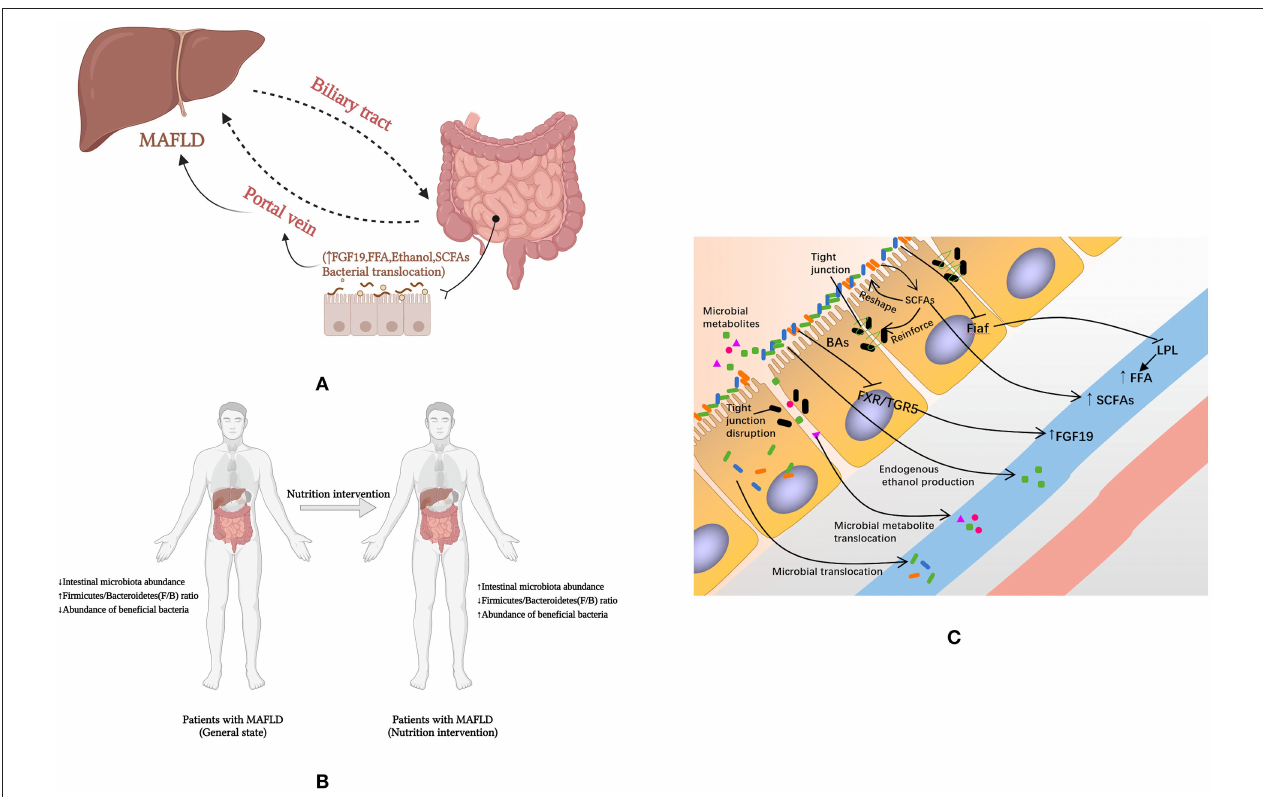
FIGURE 2 | How nutrients affect MAFLD through intestinal microenvironment and microbiota. (A) Intestinal microbial-intestinal-liver axis; (B) Macro level evidence on the effect of nutrients on MAFLD; (C) The mechanisms by which nutrients affect MAFLD through the intestinal microenvironment and microflora. FFA, free fatty acids; Fiaf, fasting-induced adipocyte factor; LPL, lipoprotein lipase; MAFLD, fatty liver disease associated with metabolic dysfunction; SCFA, short-chain fatty acid; FXR, farnesol X receptor; TGR5, Takeda G protein-coupled receptor 5; BAs, bile acids; FGF 19, fibroblast growth factor